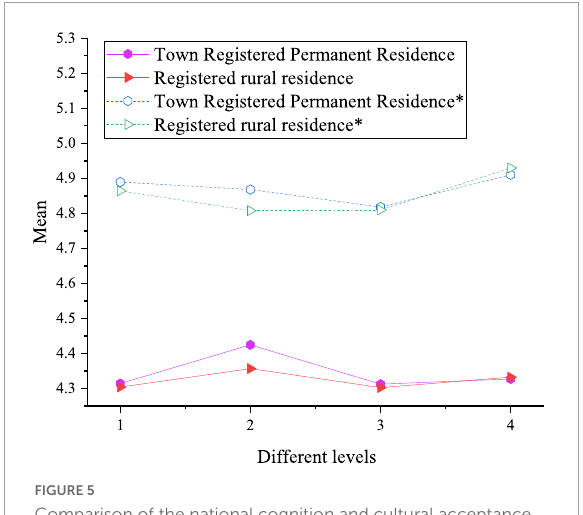
FIGURE5 Comparison of the national cognition and cultural acceptance of college students from different family backgrounds before and after reading art journals. * denotes post-test